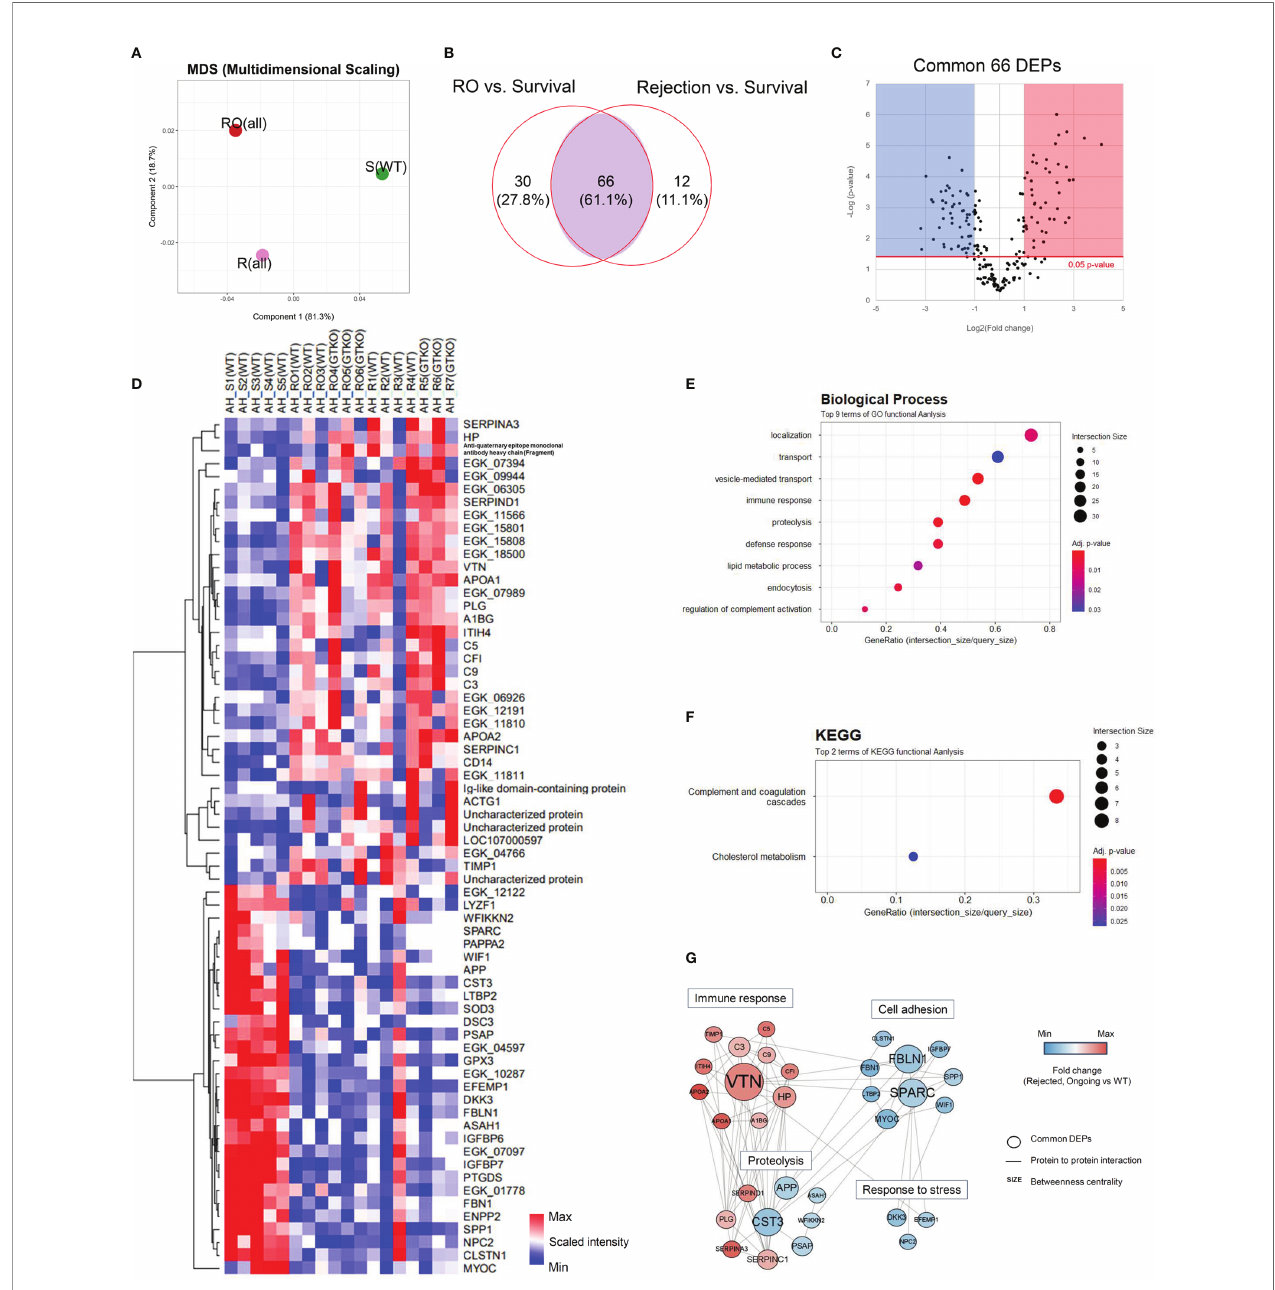
FIGURE 2 | Proteomic analysis of the aqueous humor (AH). Proteins from a non-human primate library ( Macaca mulatta ) with at least 2-fold signi fi cant ( p < 0.05) changes in the rejection ongoing (RO) and rejection (R) groups [compared with the survival (S) group] were analyzed. (A) Principal component analysis (PCA) of AH protein expression in the R, RO, and S groups. (B) Venn diagram depicting the comparison of differentially expressed proteins (DEPs) in the RO and R groups compared with the S group. A set of 66 proteins (common DEPs) exhibited a signi fi cant and more than 2-fold change in both the RO and R groups (compared with the S group). (C) A volcano plot showing the differential level of proteins in the RO and R groups compared with the S group. (D) Cluster heat map of the 66 common DEPs identi fi ed in AH. (E, F) Gene Ontology biological process classi fi cation (E) and Kyoto Encyclopedia of Genes and Genomes (KEGG) pathway enrichment analyses (F) of the common DEPs. Node size represents the gene ratio; node color represents the adjusted p -value. (G) Network modeling of the common DEPs in AH. A network model showing the biological processes affected, including the immune response, proteolysis, cell adhesion, and response to stress. The colors of the nodes represent proteins whose levels were greatly increased (red) or decreased (blue) in the RO and R groups compared with the S group. Large nodes indicate a high degree of connectivity (betweenness centrality) with other proteins in the model. Connections between nodes (gray lines) indicate either regulatory roles or physical interactions between proteins. WT, wild type; GTKO, a -1,3-galactosyltransferase